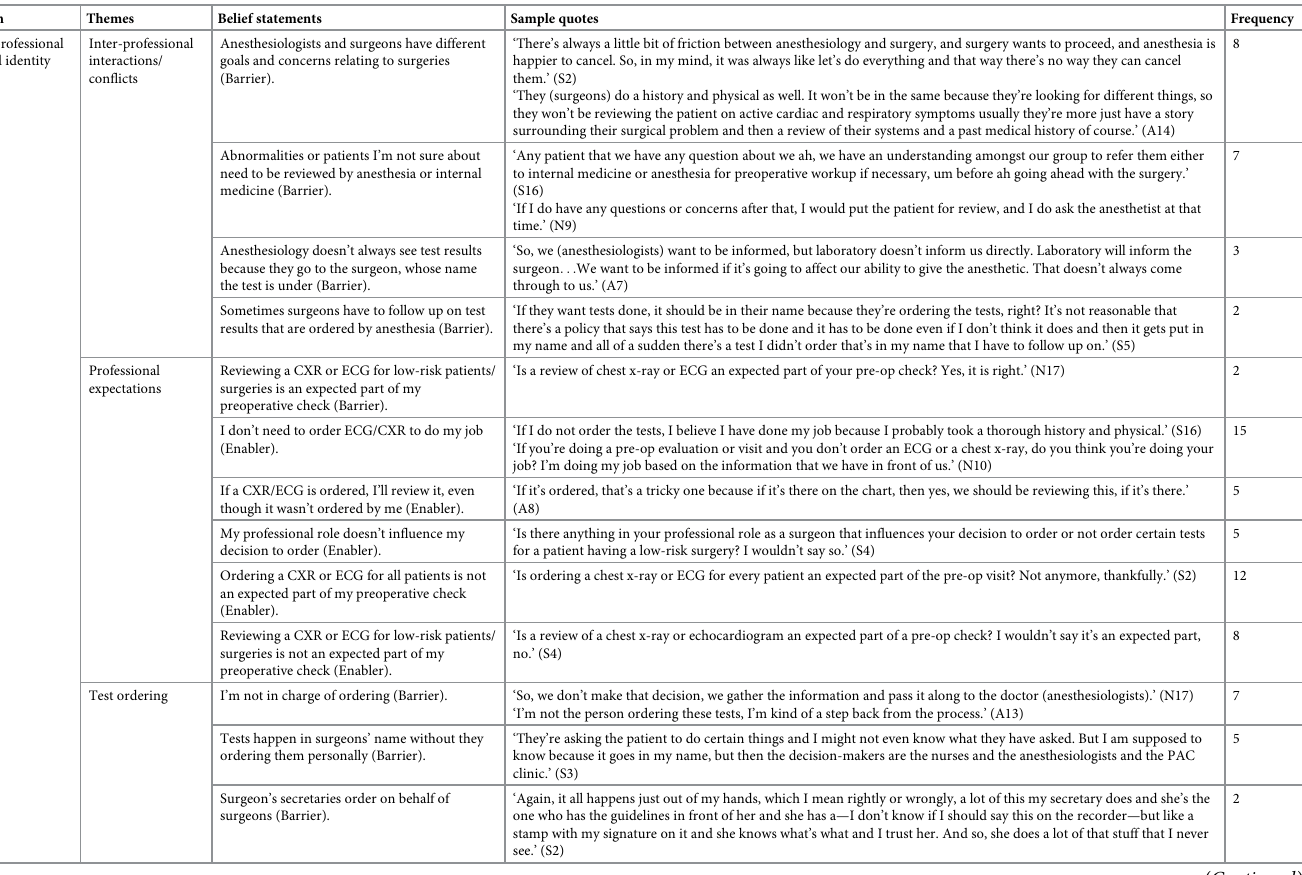
Table 1. Summary of belief statements and sample quotes from anesthesiologist, surgeons and nurses assigned to the theoretical domains identified as relevant.